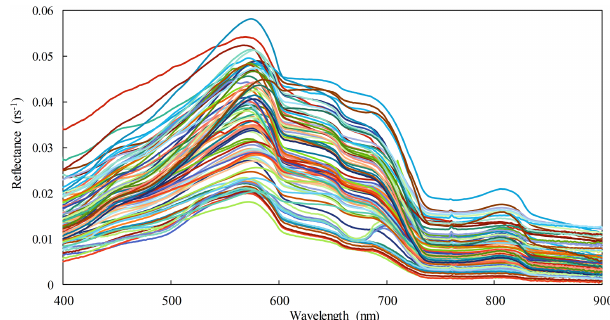
Figure 2. Remote-sensing reflectance of surface water of the 89 in situ